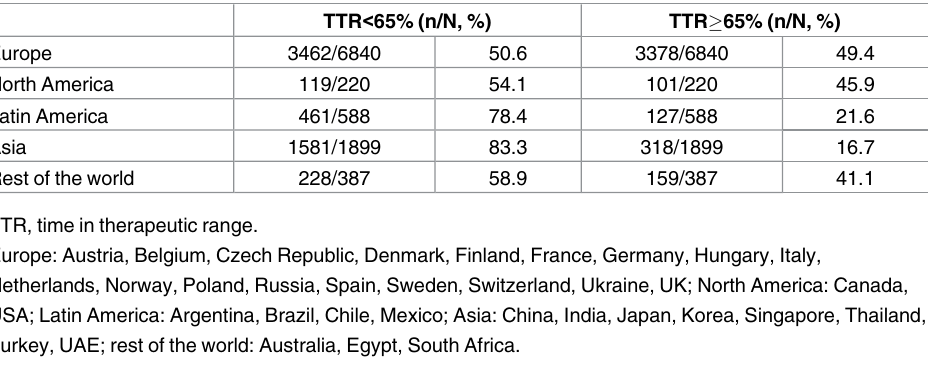
Table 2. Proportion of patients with TTR < 65% and (cid:21) 65% in different geographic